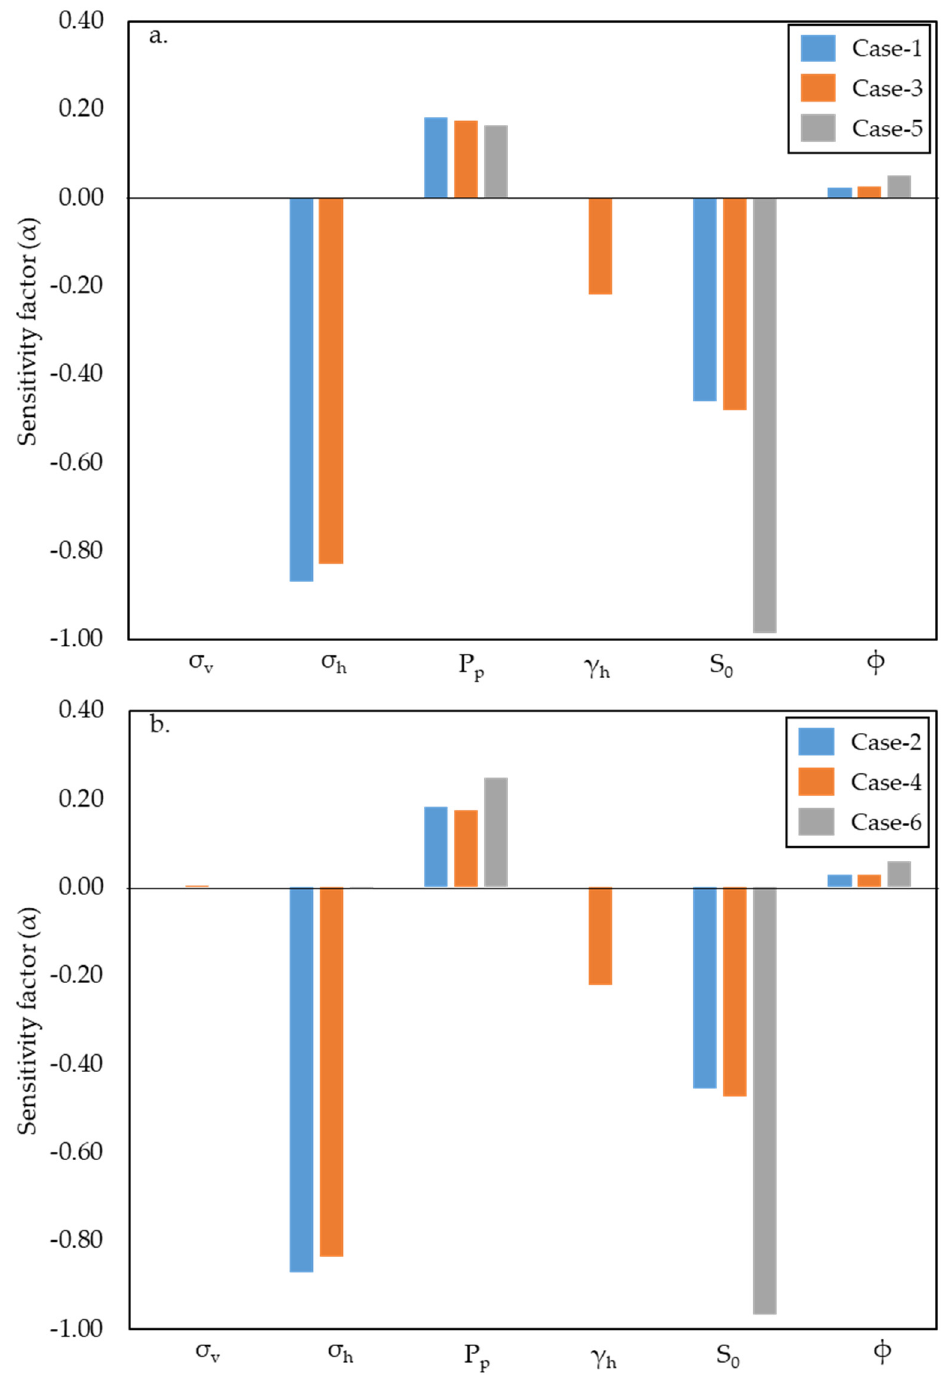
Figure 8. The sensitivity factor ( α ) shows the relations between input variables (i.e., σ v = vertical stress ; σ h = horizontal stress; P p = pore pressure; γ h = horizontal stress path; S 0 = cohesion; and ϕ = friction angle) and the responses in upper Drake ( a ) and lower Drake ( b ) units using FORM.